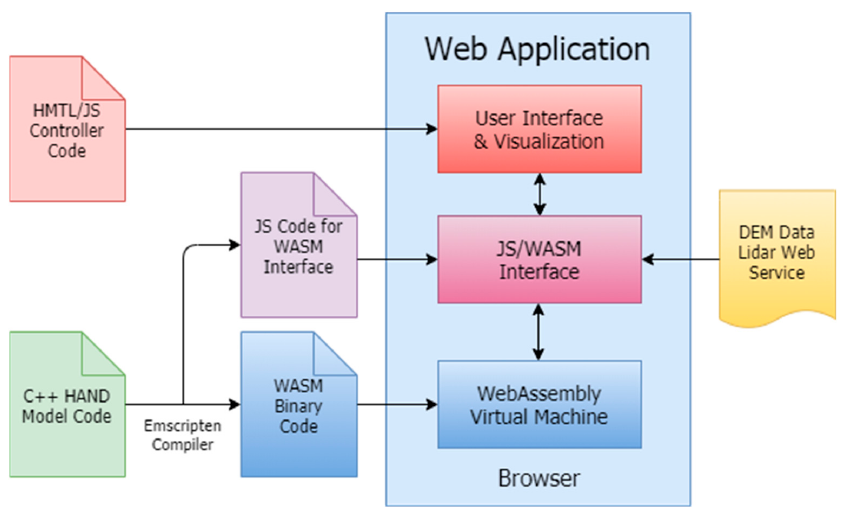
Figure 1. Architecture and components of the real-time web-based height above nearest drainage (HAND) mapping system.